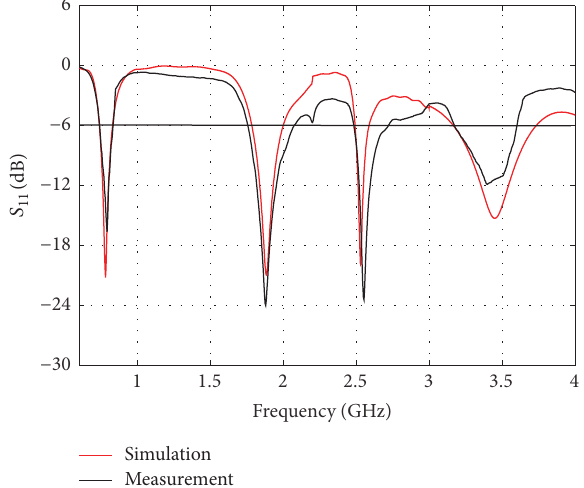
Figure 7: Simulated and measured 𝑆 11 of the proposed PIFA.